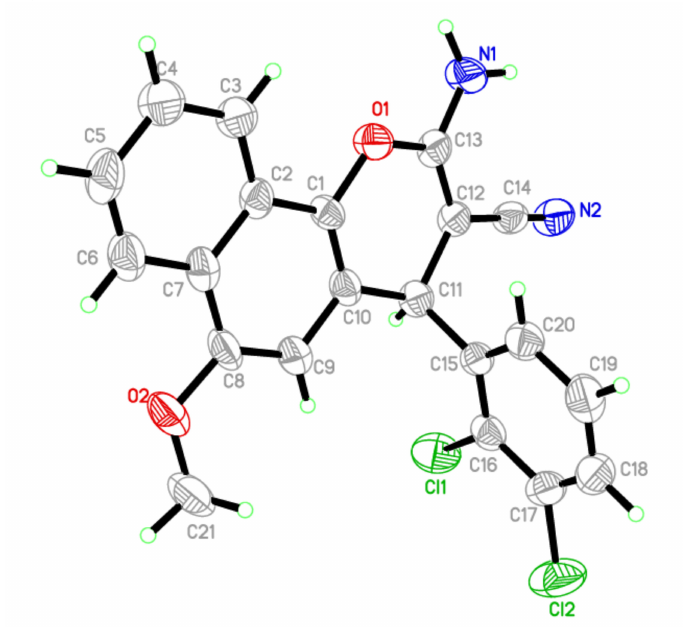
Figure 7. Crystal structure for compound 4